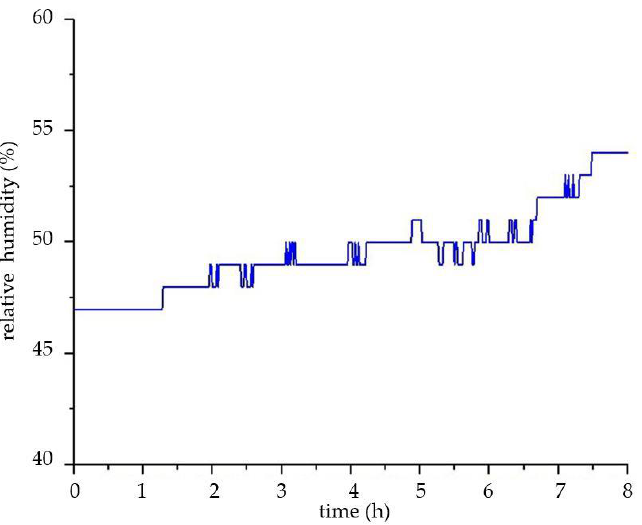
Figure 20. The curve of relative humidity.